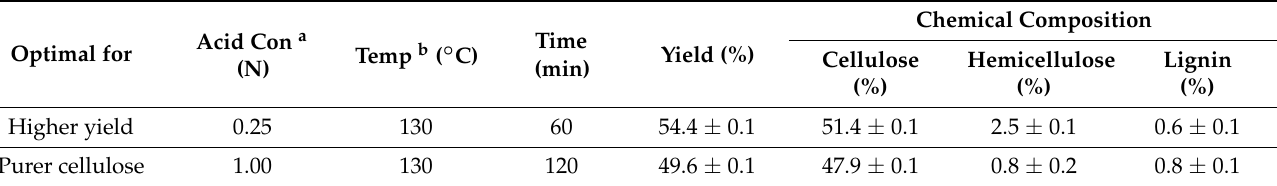
Table 4. The optimal condition of dilute acid hydrolysis on kenaf outer bast.